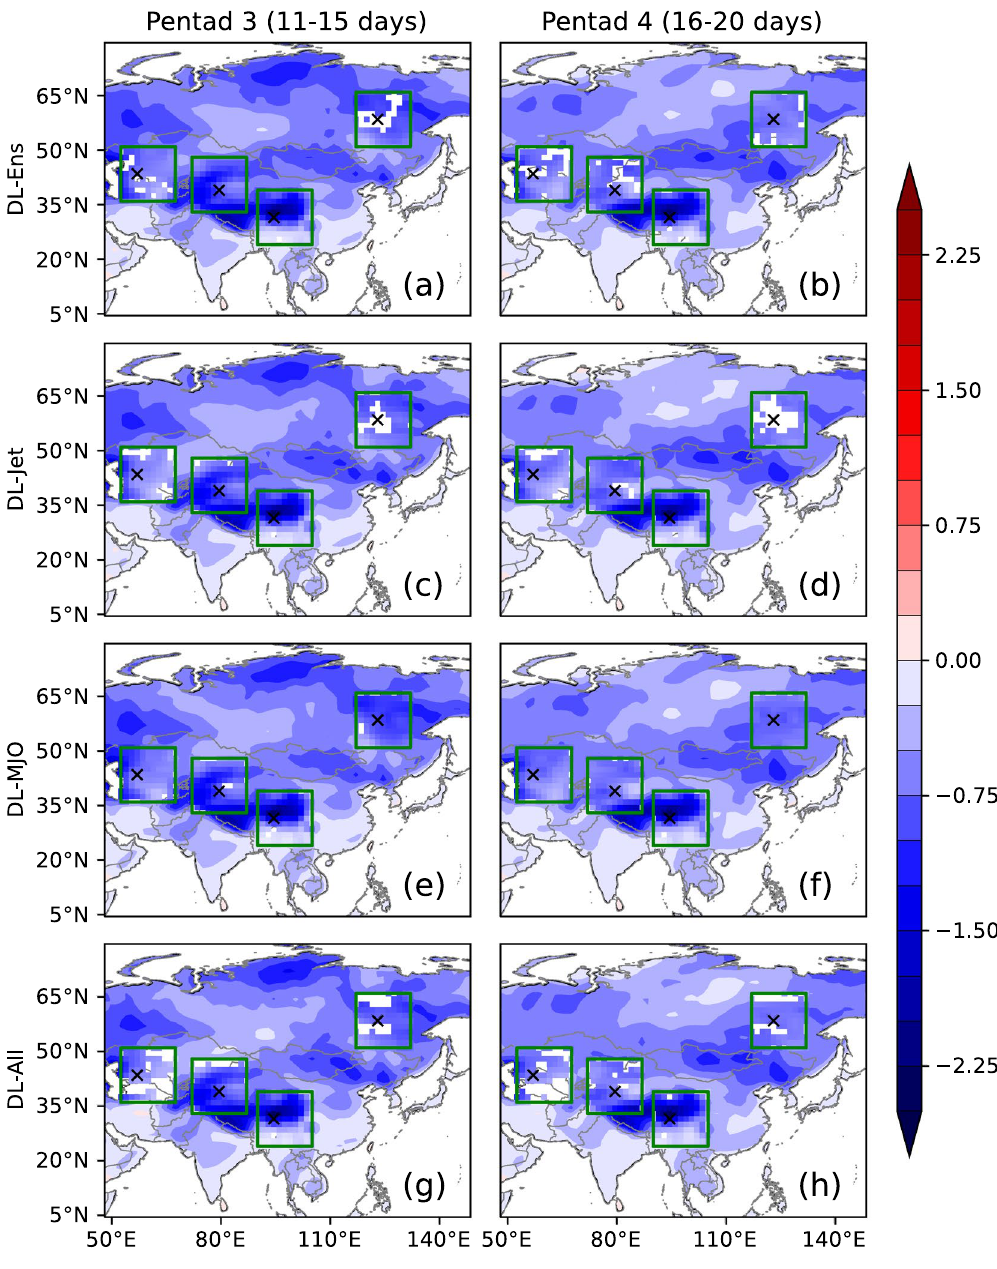
Figure 4. Same as Fig. 3, but for the differences of